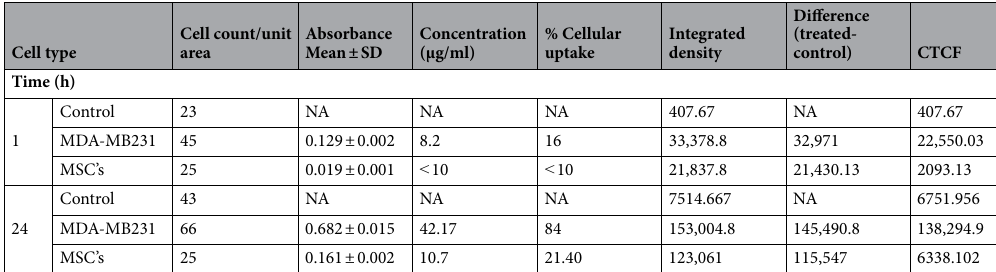
Table 3. Cellular uptake, absorbance, and fluorescence intensity variations of NC-virosome in different cells.